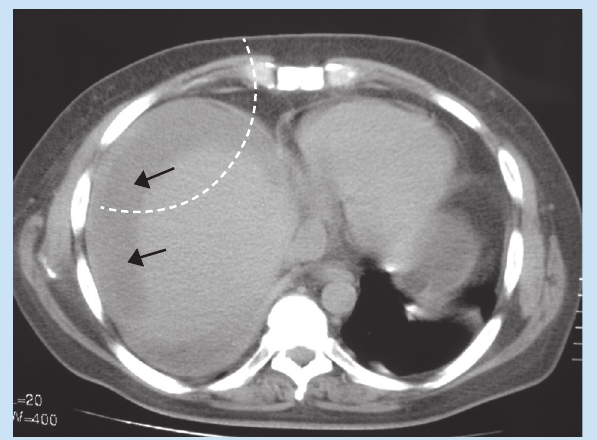
Fig. 2. Computed tomography scan showing right subphrenic collection (arrows). Dashed line showing needle course.